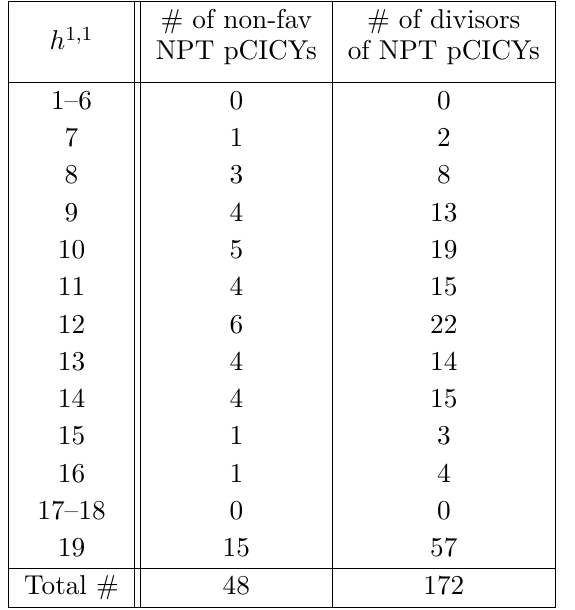
Table 13 . Number of non-favorable NPT pCICYs and their divisors for 1 ≤ h 1 , 1 ≤ 19